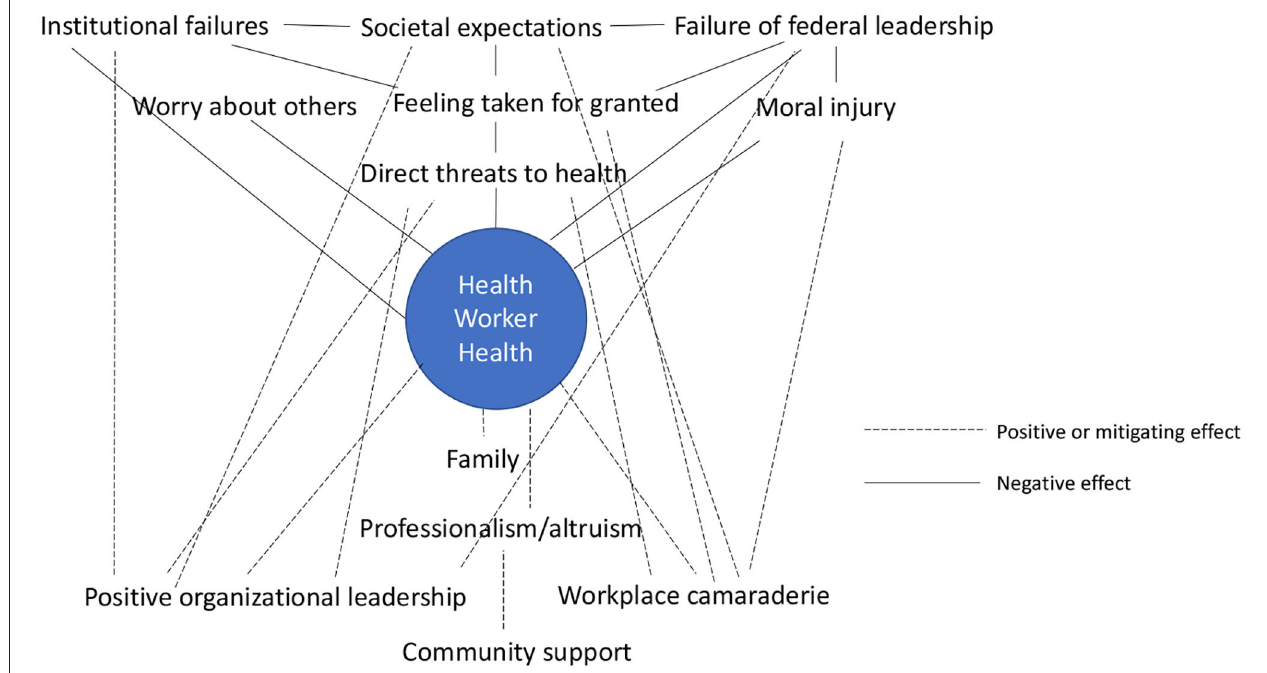
FIGURE 1 | Positive and negative influences on Health worker health across social ecological levels.